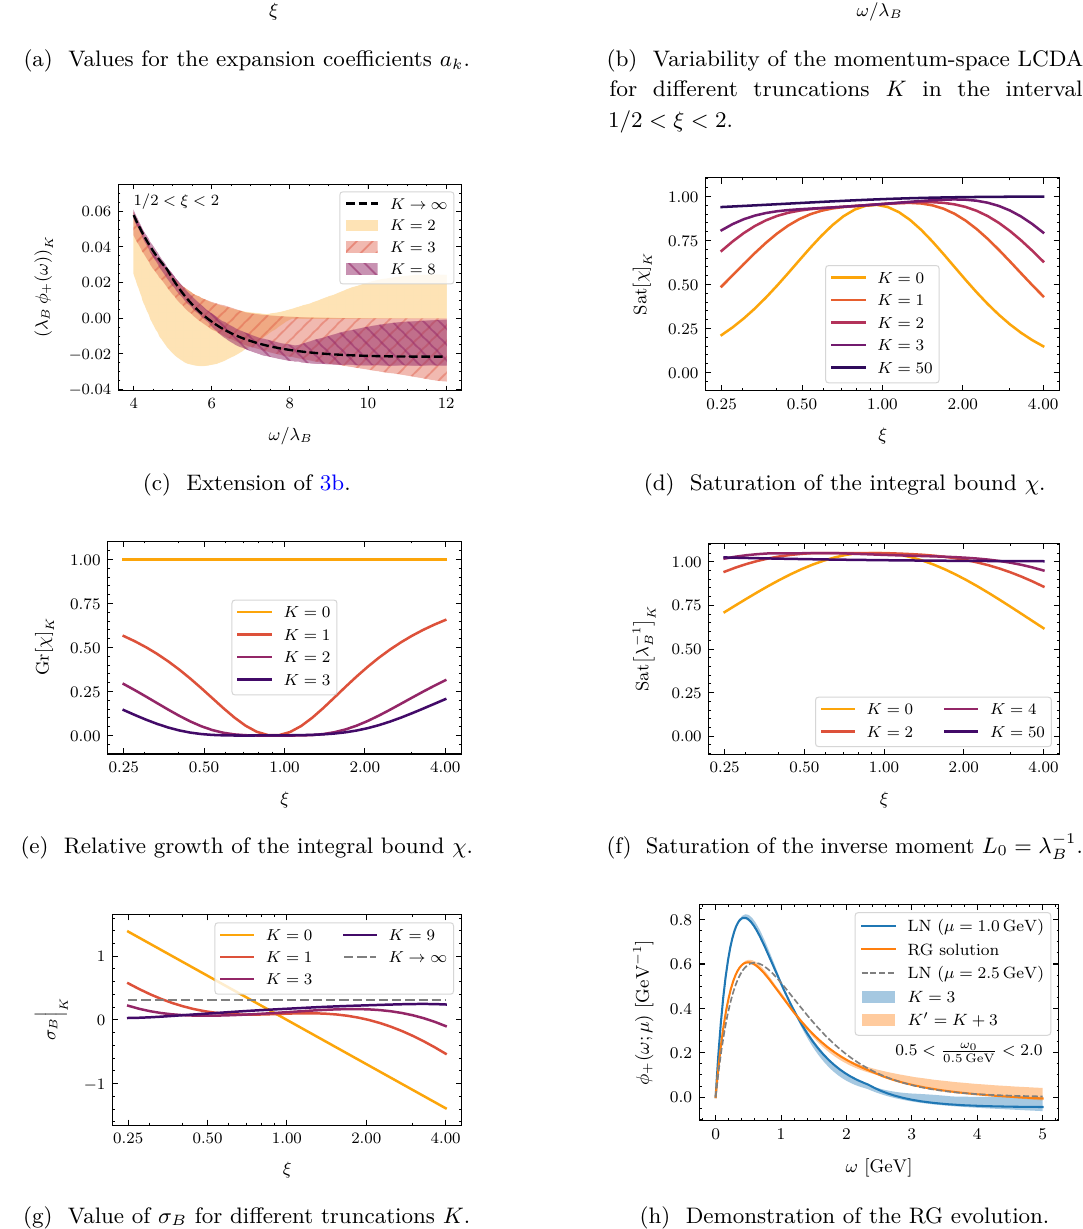
Figure 3 . Plots illustrating the truncation effects of our parametrization for the Lee-Neubert model eq. (4.15). We use the ratio ξ = ω , plotted on a logarithmic 0 /λ B